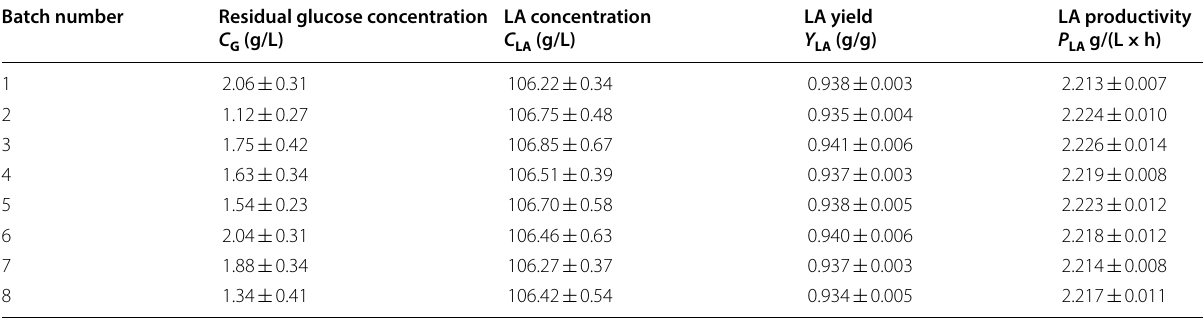
Table 6 The results of repeated batch fermentation of immobilized L. pentosus ATCC 8041 cells under optimum